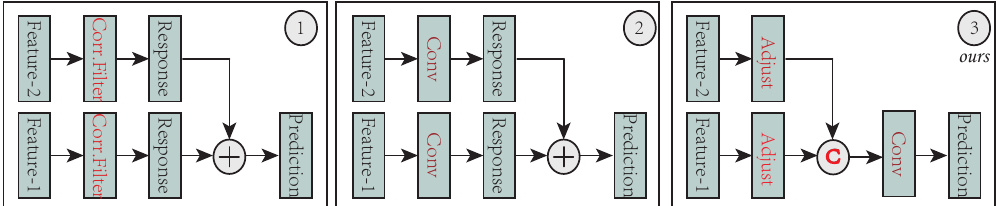
Figure 3. Three types of feature connection. (1) Independent connection that is used in traditional correlation-filter trackers (e.g., ECO [32]). Pediction is obtained by weighted summing from different correlation-filter responses. (2) By substituting a traditional correlation filter with a convolutional layer, the second type can exploit various end-to-end residual connections. CREST [38] exploits only a single convolutional layer ( conv4_3 from VGG16 ) that means feature-1 and feature-2 are the same to form a base and a residual network. The DSLT [39] leverages two convolutional layers ( conv4_3 and conv5_3 from VGG16 ) to learn the residual across multiple convolutional layers. (3) Our scheme exploits the feature adjuster (normalization) to fuse multiple convolutional layers. We learn a regression layer directly on the reinforced feature represented. The proposed scheme can easily incorporate more features without increasing the convolutional parameters.